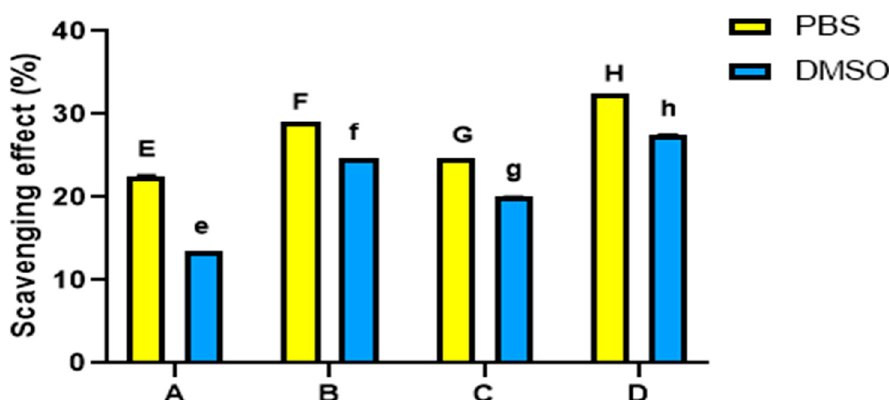
Figure 6. DPPH radical scavenging activity of honey bee hemolymph extracted in PBS or DMSO where ( A ): Bees from Port Said, ( B ): bees from Ismailia governorate, ( C ): bees from Suez governorate, ( D ): bees from Saint Catherine. Bars and error bars represent the mean values ± SEM obtained from triplicate measurements. Different letters above bars indicate significant differences (Tukey’s test, p < 0.05): uppercase letters show comparisons across PBS dissolved samples; lowercase letters show comparisons across DMSO dissolved samples.